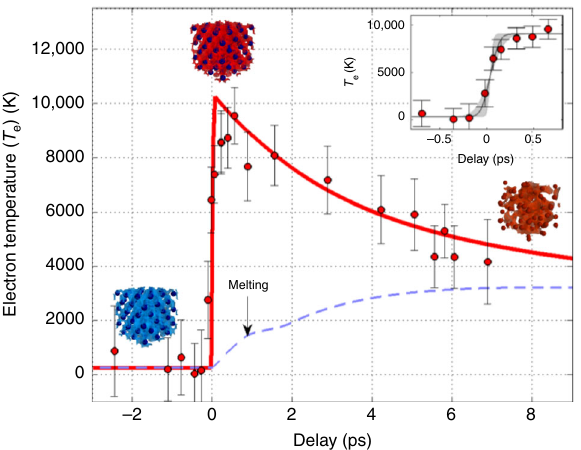
Fig. 4 Time evolution of the electron temperature. The data deduced from time-resolved XAS measurements (full circles) are compared with the two- temperature hydrodynamic calculation (plain line). The calculated ion temperature is also plotted (dashed line). The incident fl uence is 1 J cm − 2 . The experimental data indicate a rise-time of 75 ± 25 fs (line and shadowed area in the inset). The gradual decrease observed at longer time is well reproduced by the model and is understood as the electron − ion thermal equilibration. Error bars are calculated from the integrated standard deviation within the pre-edge in the XAS data series